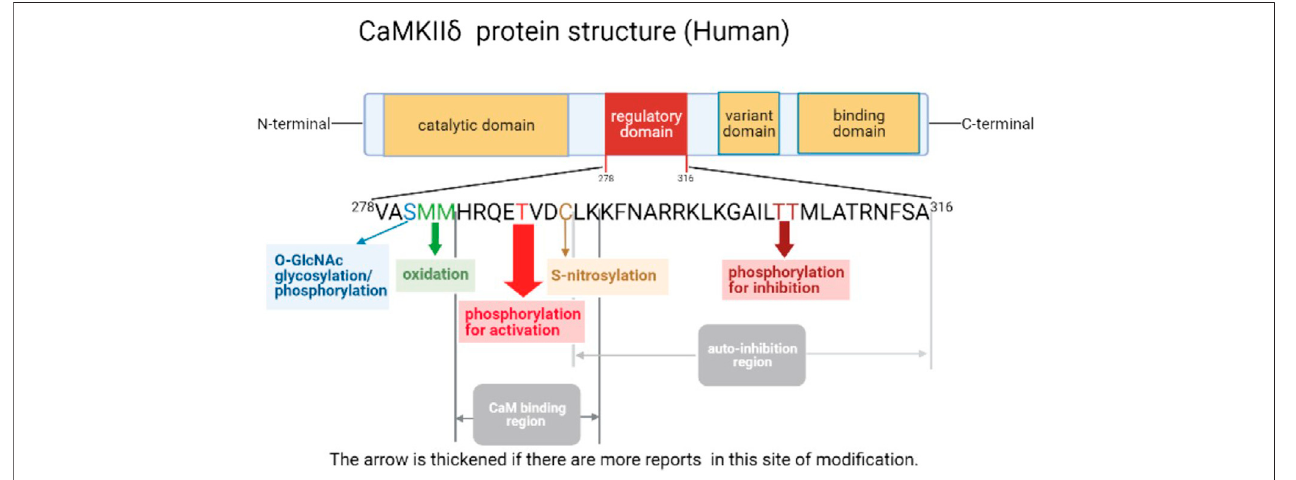
FIGURE 2 | The effect of CaMKII δ related pathway in cardiomyocyte during